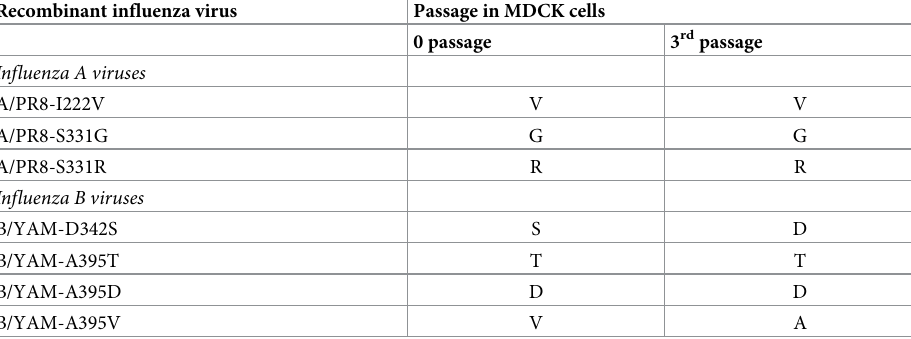
Table 4. Genetic stability of NA substitutions among recombinant influenza A and B viruses after three subse- quent passages in MDCK cells. Recombinant influenza